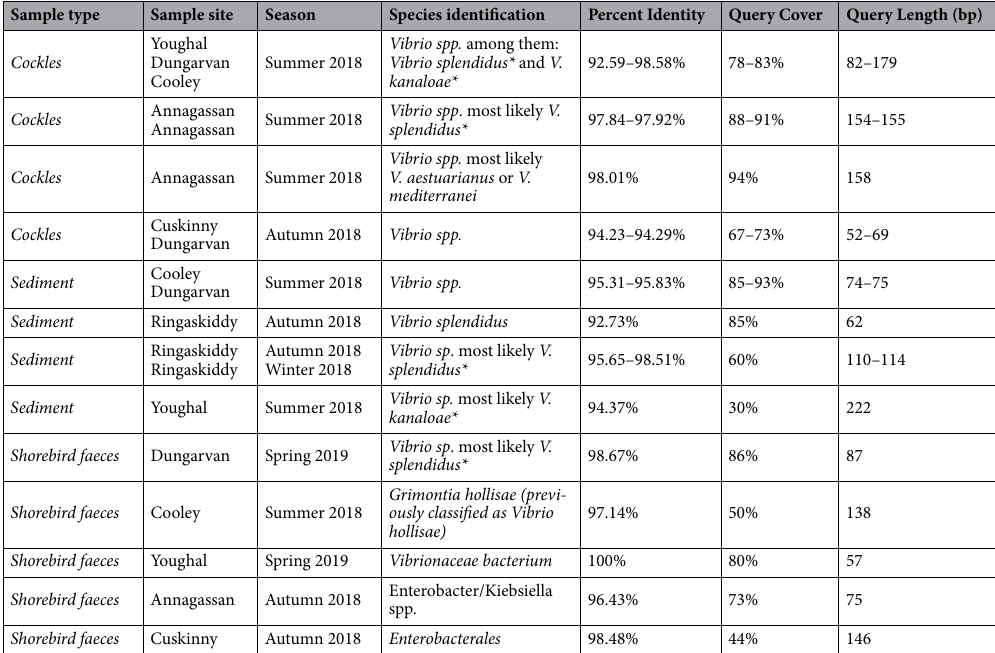
Table 3. Description of the Blast results obtained from the sequenced DNA of cockles, seabird faeces and sediment samples using generic Vibrio primers. (*) Same strains of Vibrio spp. were identified in cockle samples and sediment/faecal